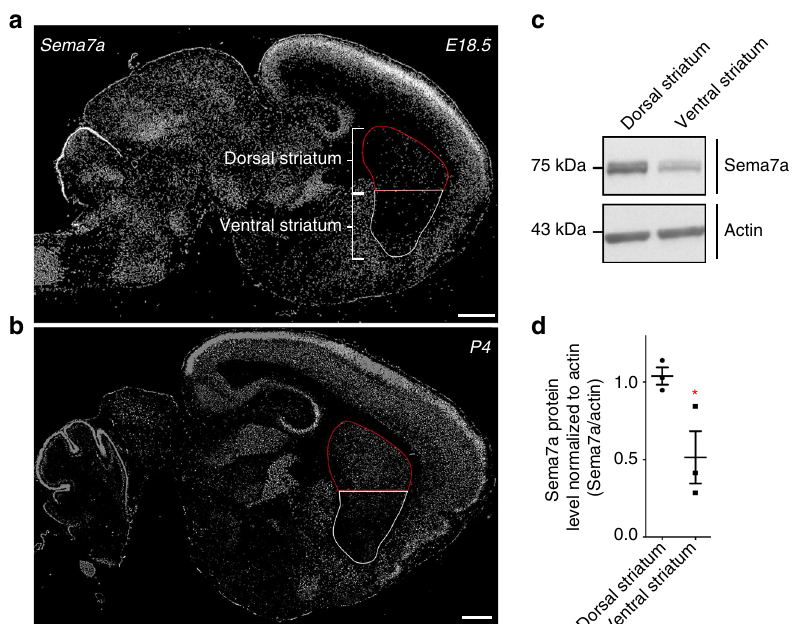
Fig. 5 The axonal guidance repellent cue Sema7a shows higher expression in the dorsal than in the ventral striatum. a , b In situ hybridization for Sema7a on a sagittal section from embryonic day 18.5 and from post-natal day 4 mouse brains (from Allen Brain Atlas). The dorsal striatum (delineated in red) expresses more Sema7a than the ventral striatum. c , d Western blot and quanti fi cation of Sema7a protein level in the dorsal and ventral striatum at P1 ( n = 3, two-tailed unpaired t test, p = 0.0418). Scale bar: 500 µ